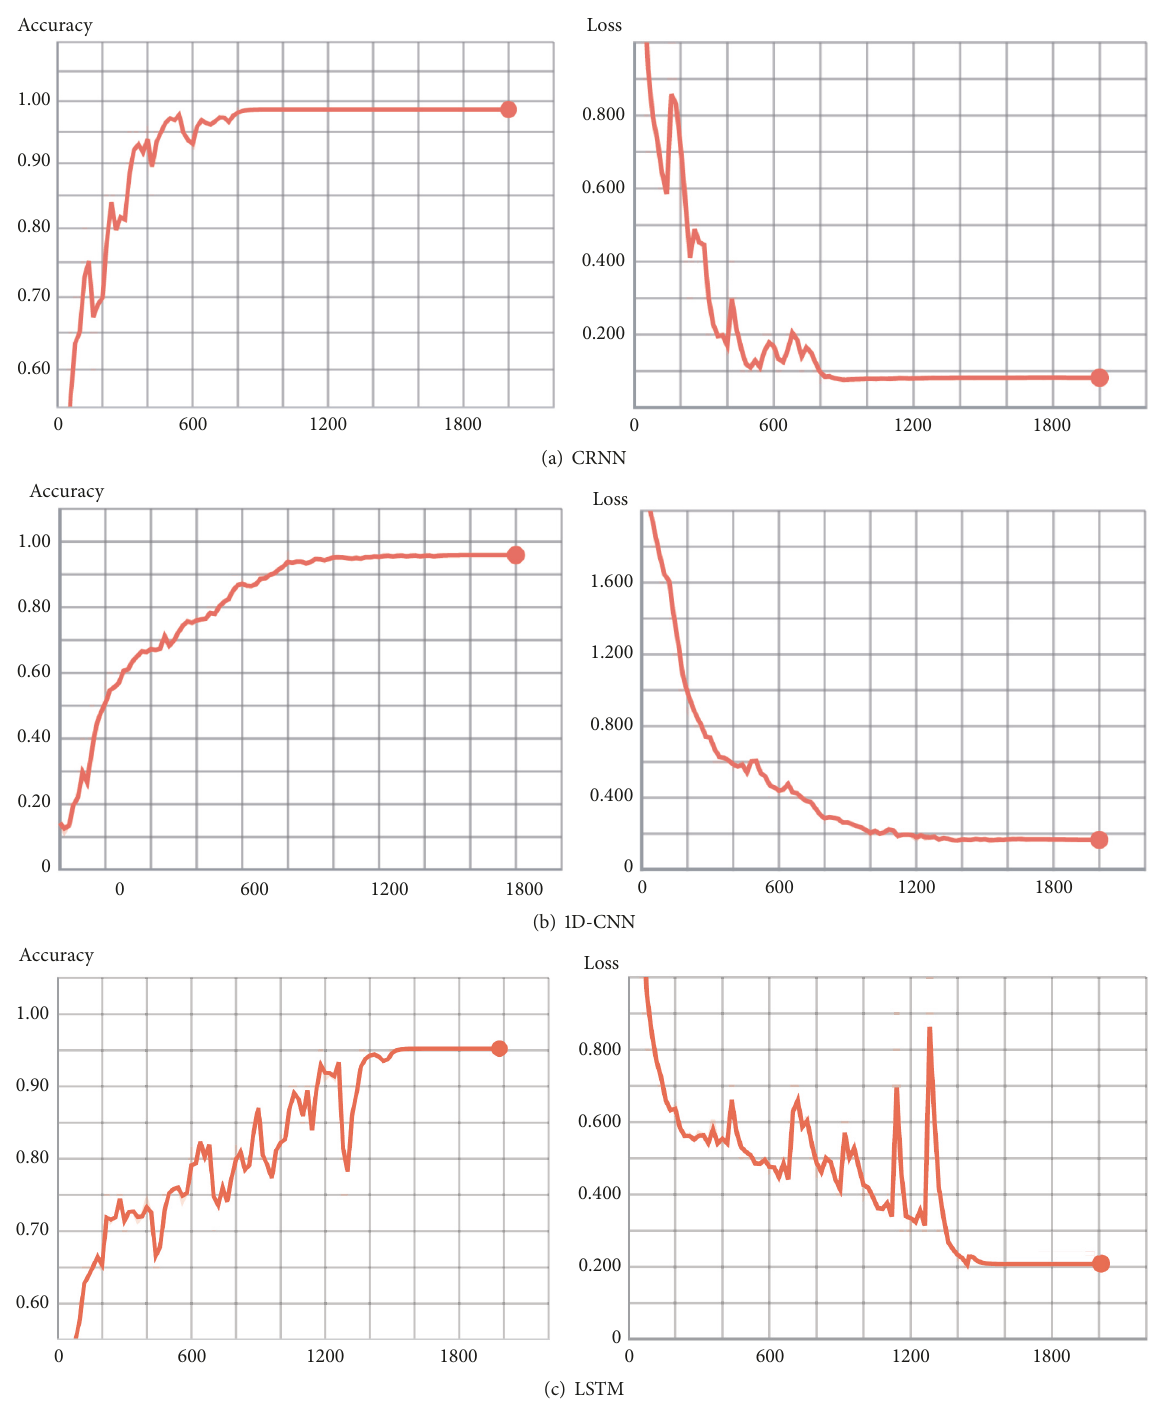
Figure 8: The accuracies (y-axis) of CRNN, 1D-CNN, and LSTM for 2000 iterations on HST test sets. x-axis: training iterations used.